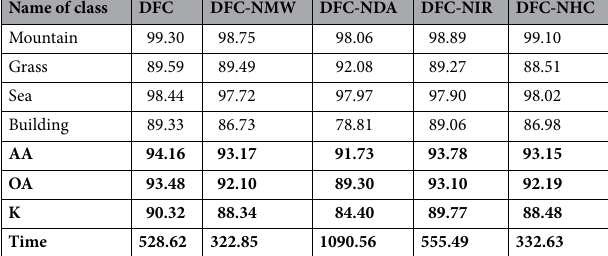
Table 3. Classification results for SanFrancisco dataset achieved by using 750 training samples per class.